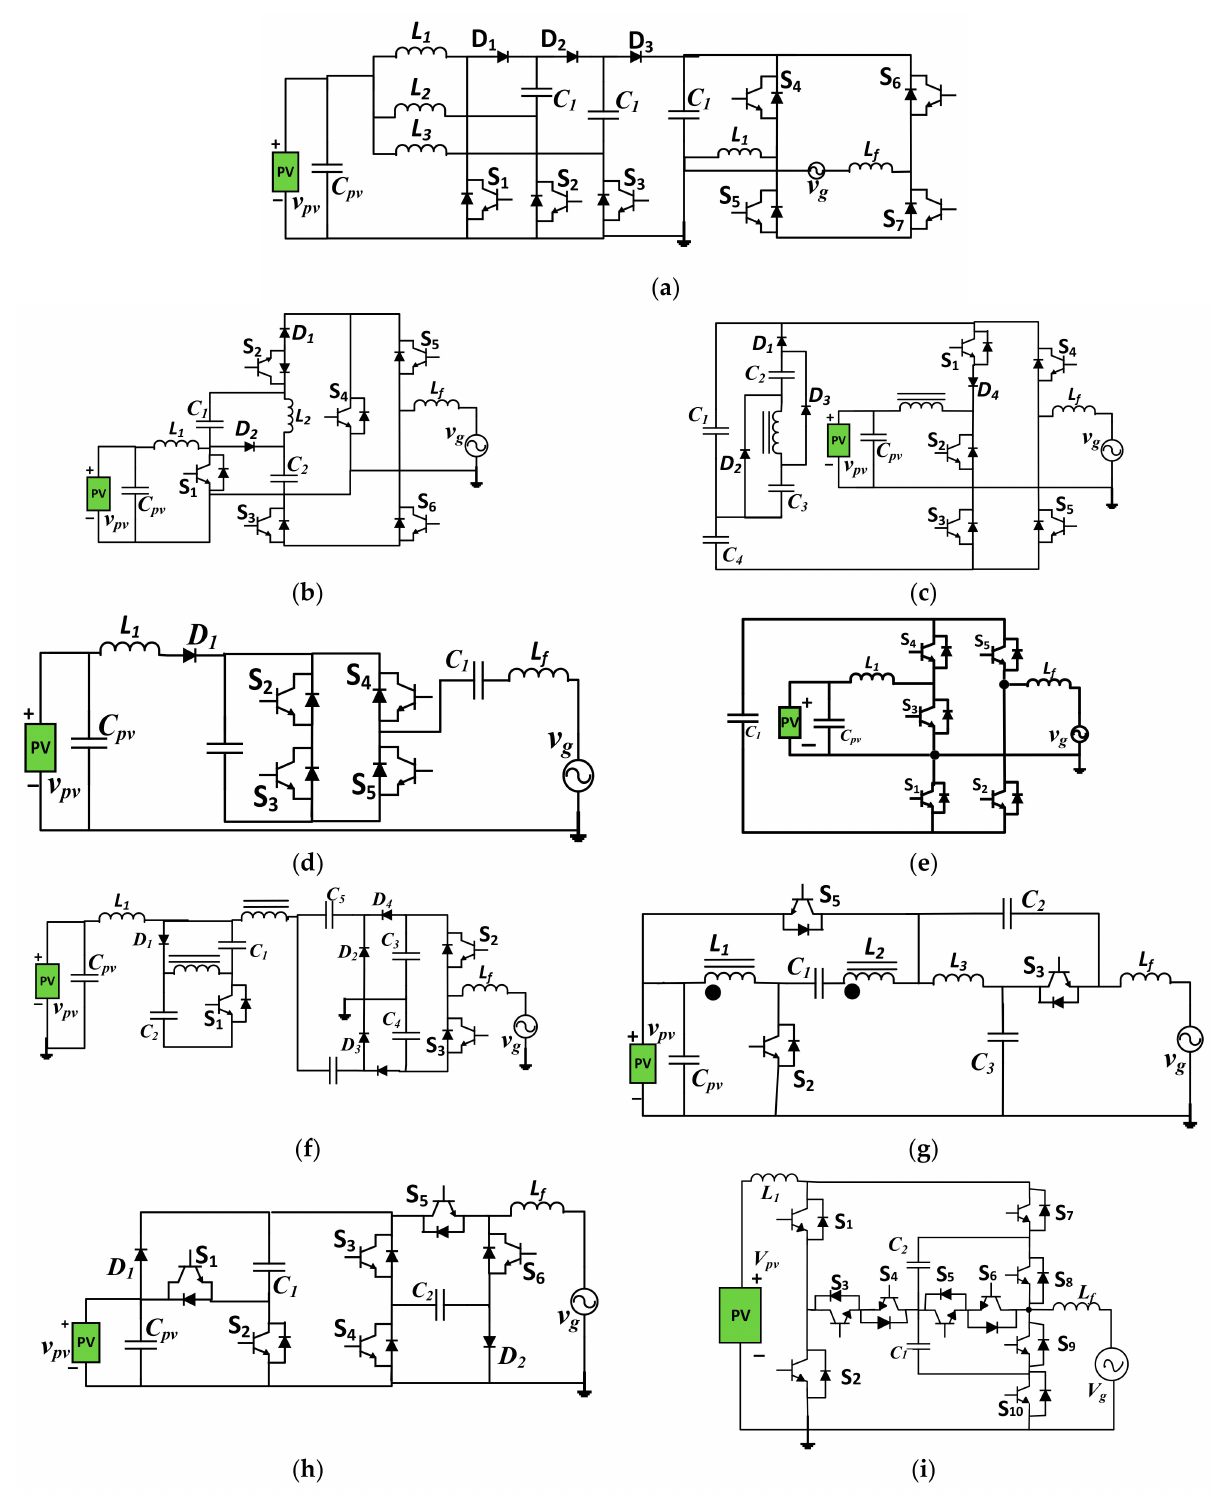
Figure 5. Voltage-source common-grounded (CSCG) converters (boosting type). ( a ) Converter presented in the work of [54], ( b ) converter presented in the work of [55], ( c ) converter presented in the work of [56], ( d ) converter presented in the work of [57], ( e ) converter presented in the work of [58], the work of [59], ( f ) converter presented in the work of [60], ( g ) converter presented in the work of [61], ( h ) converter presented in the work of [62], ( i ) converter presented in the work of